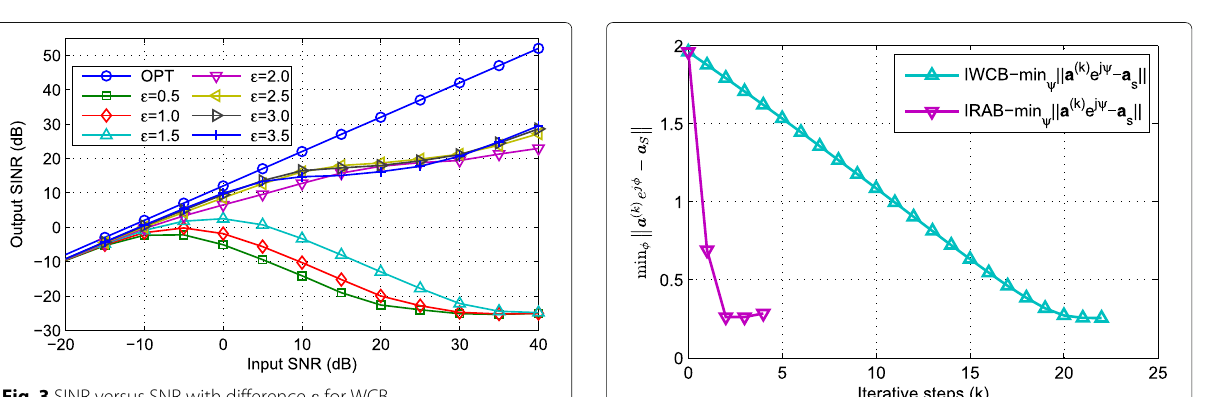
Fig. 3 SINR versus SNR with difference ε for WCB DLWCB: The diagonal loading approach of WCB, which is proposed in [23]. Its diagonal loading level has the same form with (22). Notice that the DLWCB cannot be imple- mented in practice, actual P S and P N are used to calculate the diagonal loading level in the simulations. The norm bound of steering vector error is set as ε DLWCB = 1.1 × ε 0 , except for example 5.